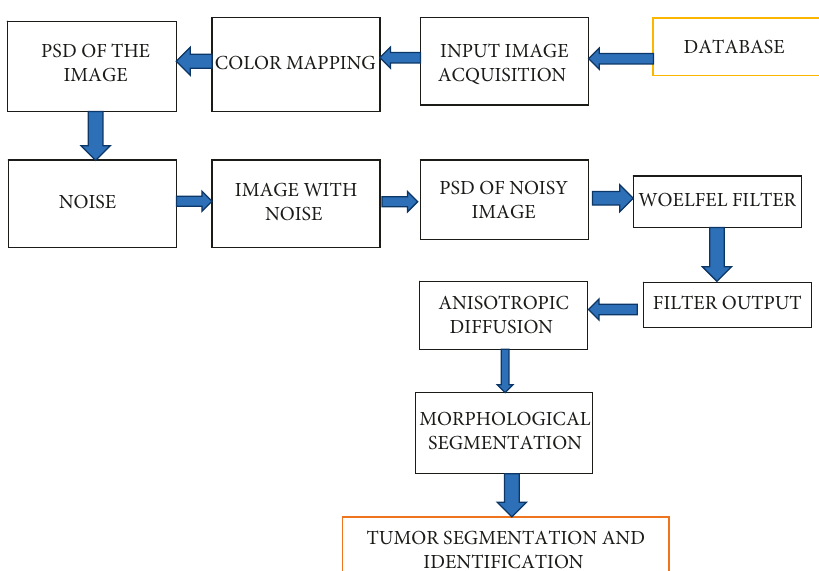
Figure 1: Block diagram for medical image denoising via Woelfel image noise filter.